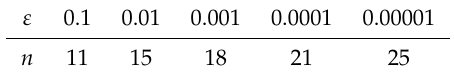
Table 7. Number n of iterations needed by the a posteriori estimate if started with ( 100,20 ) .